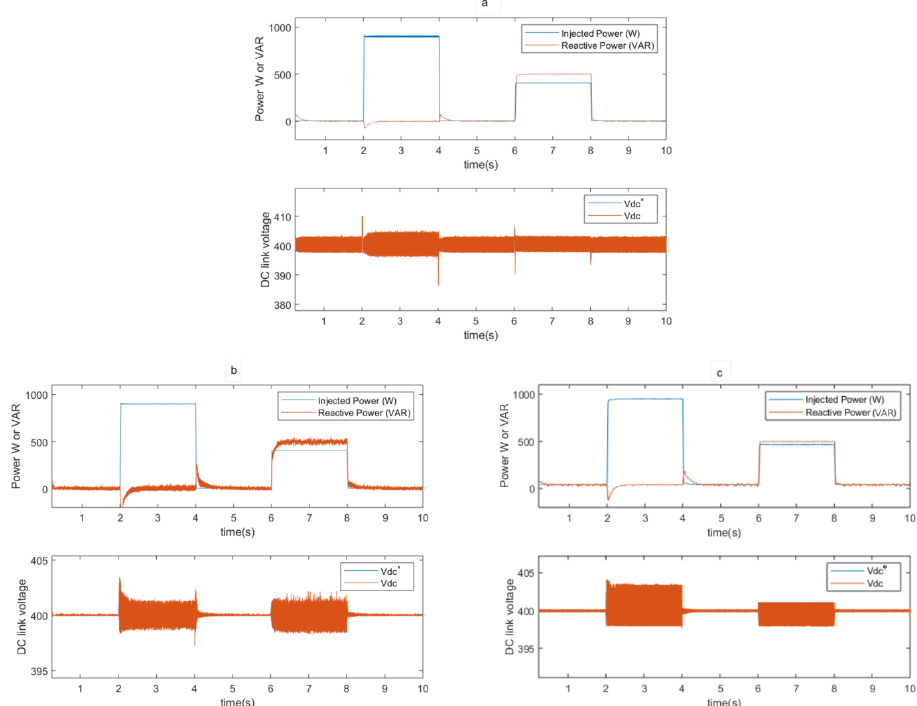
Figure 6. Response of the grid-side converter in the transient regime for C = 30 µ F. ( a ) PI controller, ( b ) SMC1 controller, and ( c ) SMC2